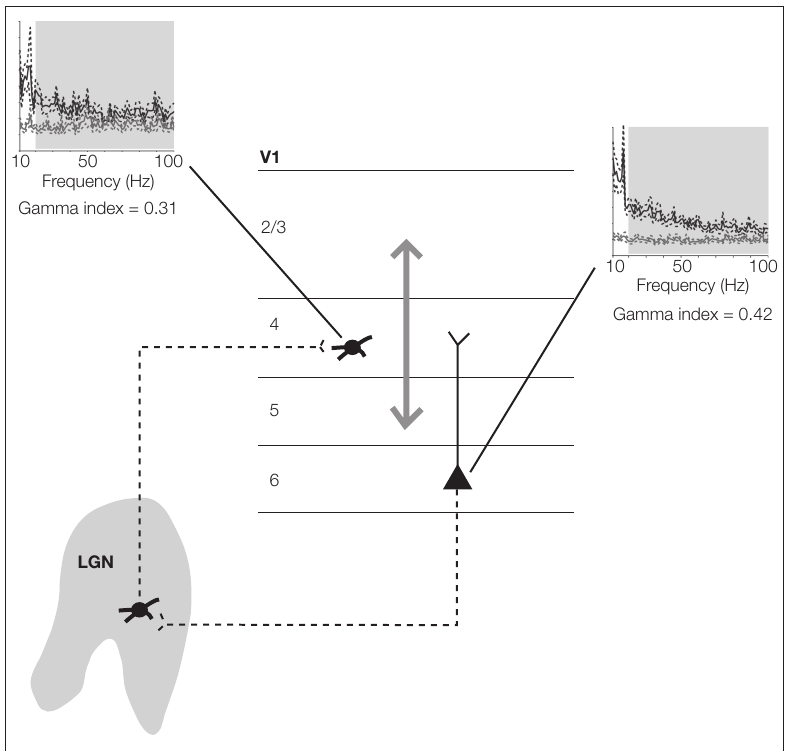
Figure 1 | Simplified schematic of geniculocortical, corticogeniculate, and local cortical circuits interconnecting neurons in the LgN and V1. Dendrites are depicted by solid lines and axons are depicted by dashed lines. The gray arrow represents a host of local cortical circuits within V1. Power spectra illustrate average power in autocorrelograms (black lines) and shuffled correlograms (gray lines) for layer 4 input neurons and layer 6 feedback neurons (dashed lines represent standard error). The extent to which the black lines lie above the gray lines indicates the amount of spectral power beyond that expected from firing rate alone (quantified with the gamma index). Light gray boxes outline the gamma-frequency band. Numbers beneath the power spectra indicate average gamma index values across samples of layer 4 input neurons and layer 6 output neurons (adapted from Briggs and Usrey,